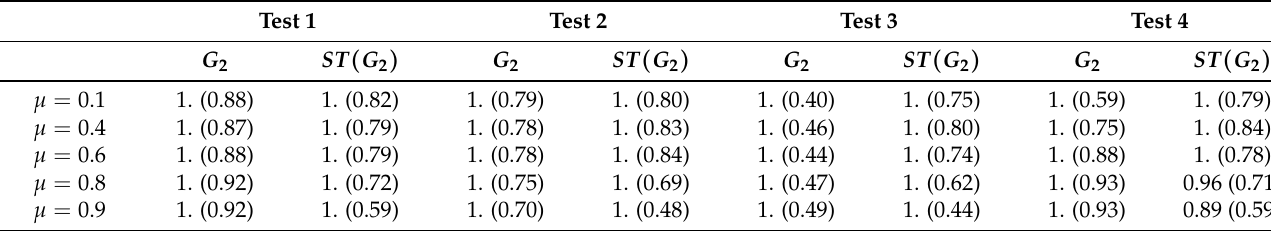
Table A3. Portion of representative variable estimates contained in the proper reference block of variables ( main value ) and corresponding to the ground truth representative variables ( between brackets ). Each portion was computed on 100 simulated graphs ( G 2 ) and their corresponding maximum spanning trees ( ST ( G 2 ) ). For each group of 100 graphs, a different strength µ of the undesirable relations is